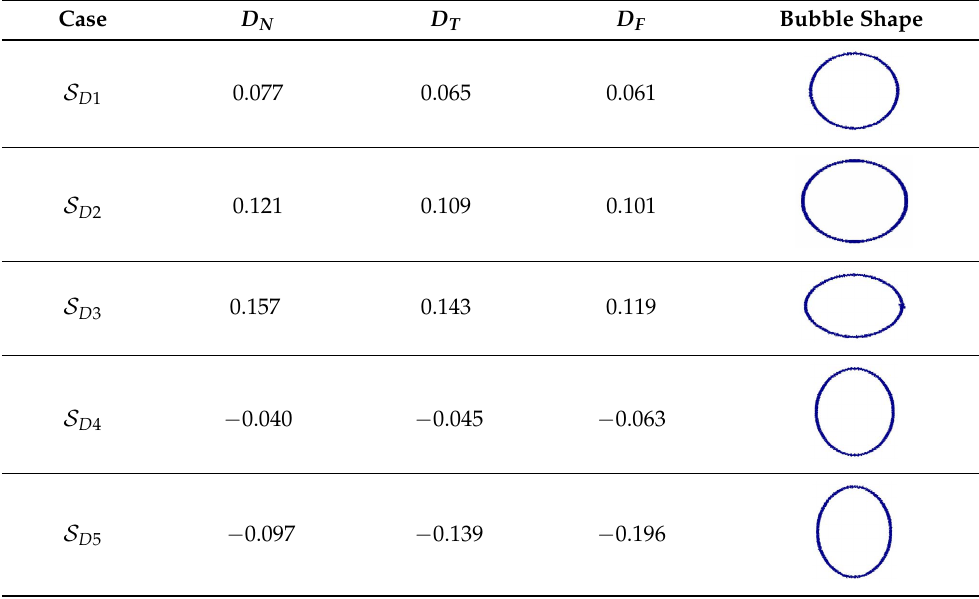
Table 4. Comparison of numerical (N) and theoretical results (Taylor et al. [42]: Equation (30) and Feng [44]: Equation (32) of the droplet deformation (D) for different combinations of conductivity and